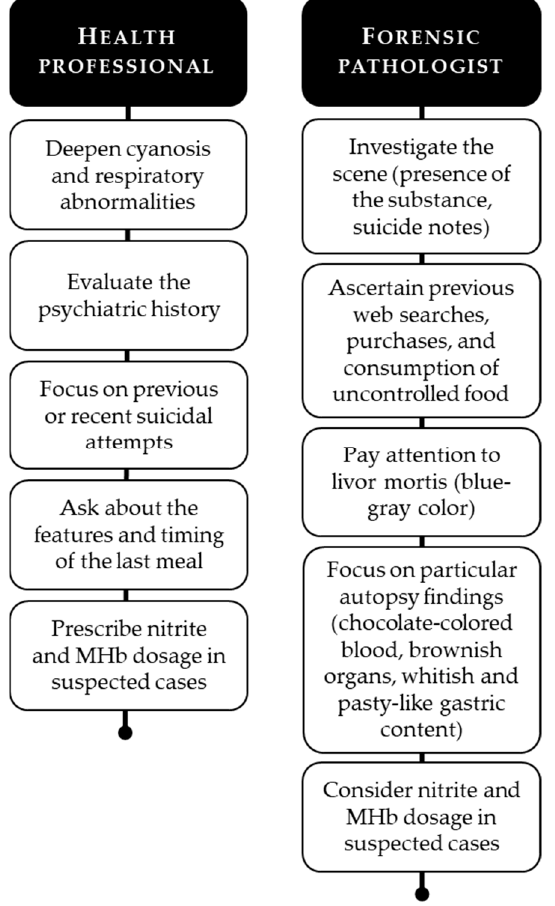
Figure 6. Practical advice for healthcare professionals and forensic